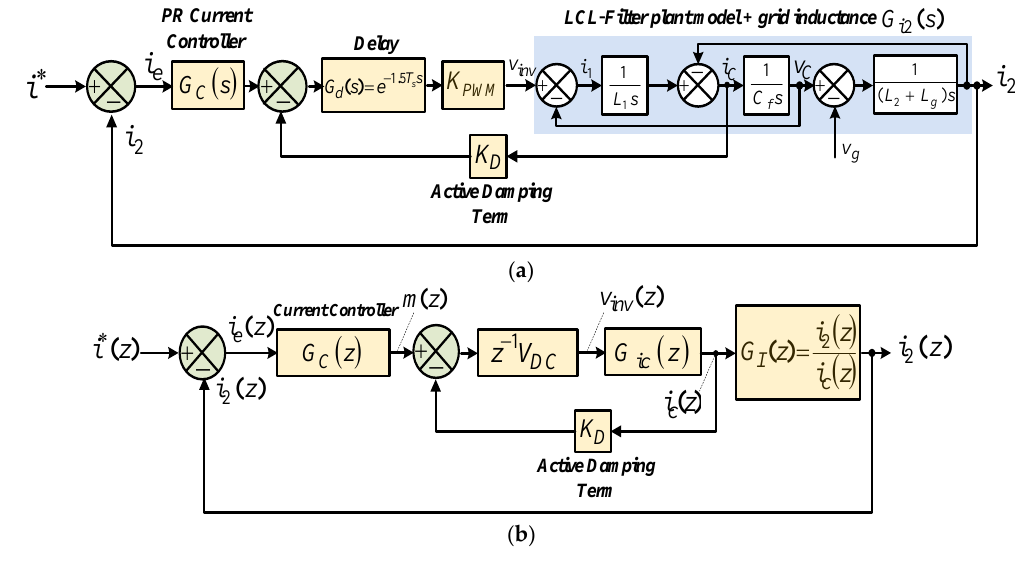
Figure 7. Block diagram of grid-side current control scheme with proportional capacitor current feedback (CCF) active damping (AD): ( a ) s -domain; and ( b ) z -domain.